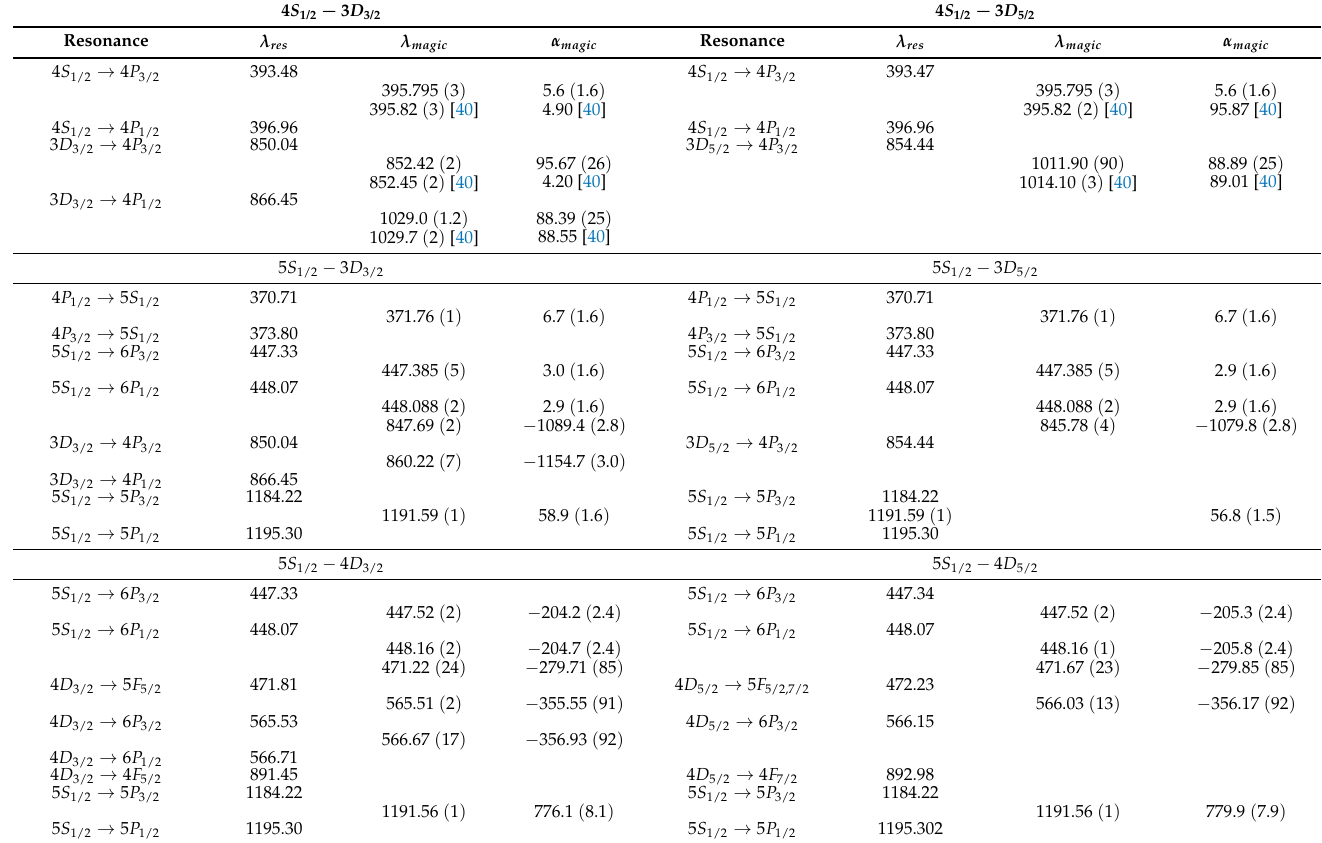
Table 2. Magic wavelengths λ magic (in nm) with their corresponding polarizability α n ( ω ) (in a.u.) for + ion and their comparison with ( 4,5 ) S − 3 D − 4 D 1/2 3/2,5/2 and 5 S 1/2 3/2,5/2 transitions in Ca